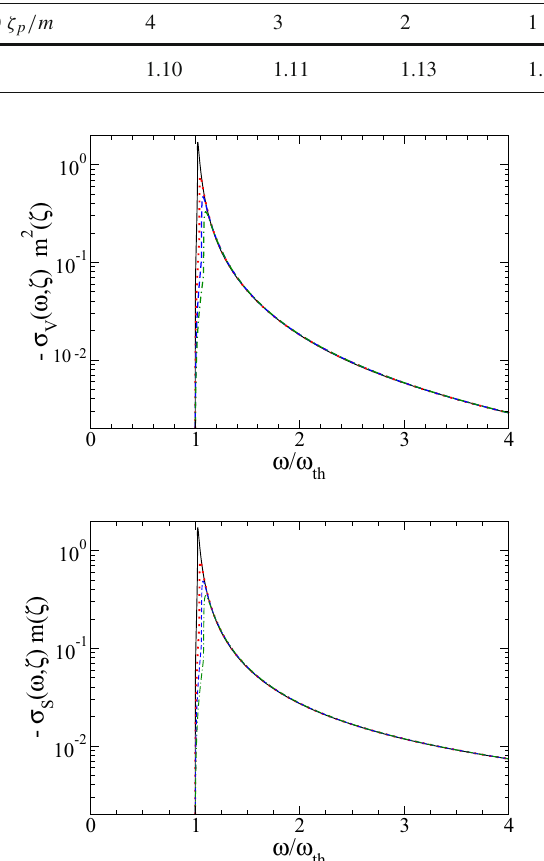
Fig. 2 The first iteration of the Källén–Lehman weights for the fermionic propagator, Eq. (15), for different values of the IR-regulator, ζ p . The threshold is given by tor weight, σ V (ω,ζ) . Lower panel: scalar weight σ S (ω,ζ) . Solid line: ζ p = 0 . 01 m (ζ) . Dotted line: ζ p = 0 . 02 m (ζ) . Dashed line: ζ = 0 . 03 m (ζ) . Dash-dotted line: ζ p